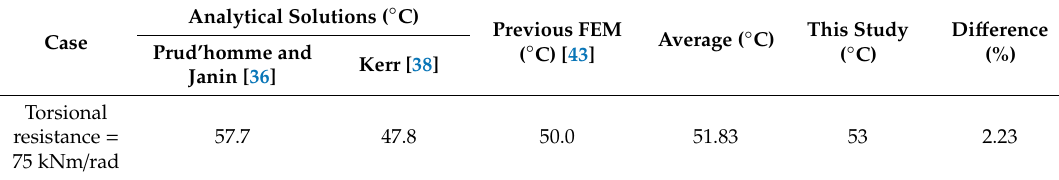
Table 2. Buckling temperatures for model